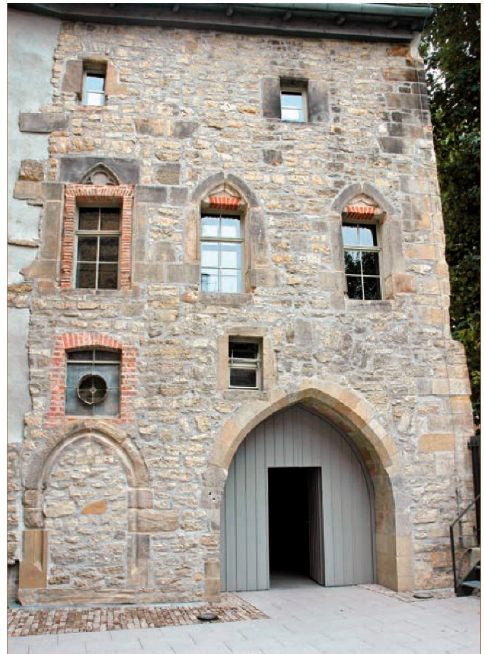
Figure 3. Northern Façade (Albrecht von Kirchbach, used with permission).